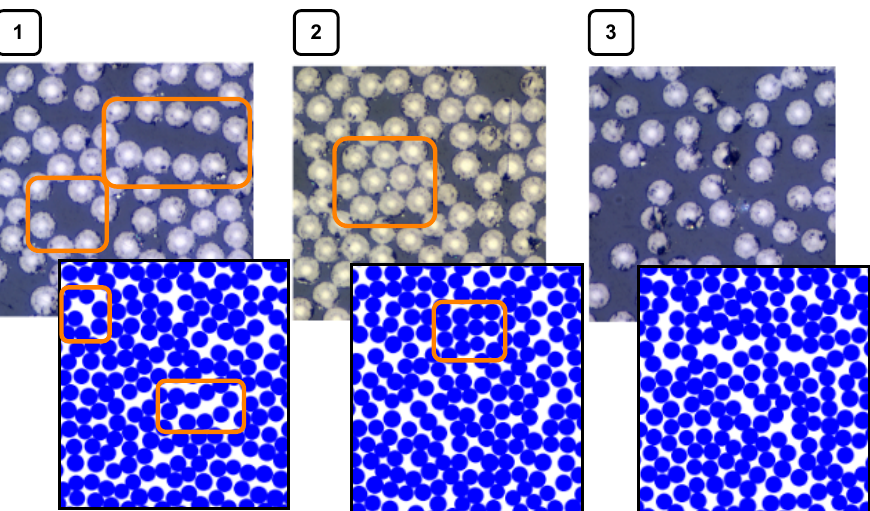
Figure 12. Comparison of actual microstructure and the generated RVE fiber distribution. The differ- ent images show ( 1 ) how smaller-matrix-dominating areas are captured, ( 2 ) how areas with tightly packed fibers are captured, and ( 3 ) how sparsely scattered fibers are difficult to